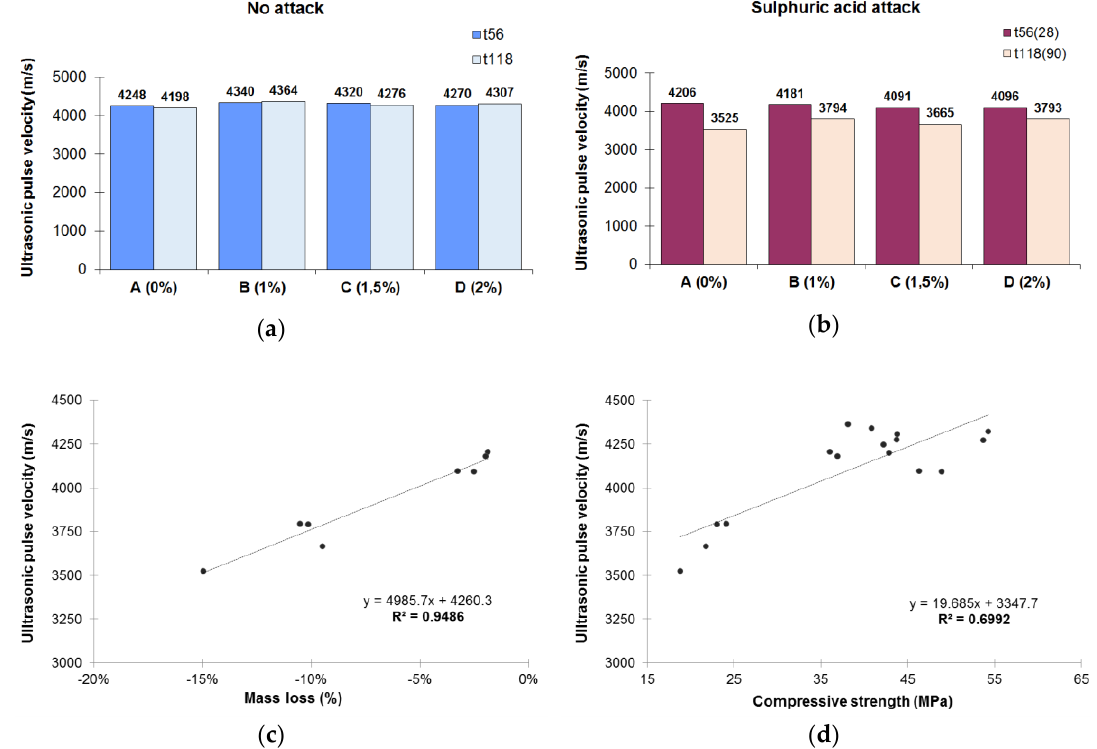
Figure 6. ( a ) Ultrasonic pulse velocity of mortars kept in a nonaggressive environment at t 56 and t 118 . ( b ) Ultrasonic pulse velocity of mortars exposed to a sulphuric acid solution for 28 and 90 days. ( c ) Correlation between ultrasonic pulse velocity (m/s) and mass loss (%) after the acid attack. ( d ) Correlation between ultrasonic pulse velocity (m/s) and compressive strength (MPa).